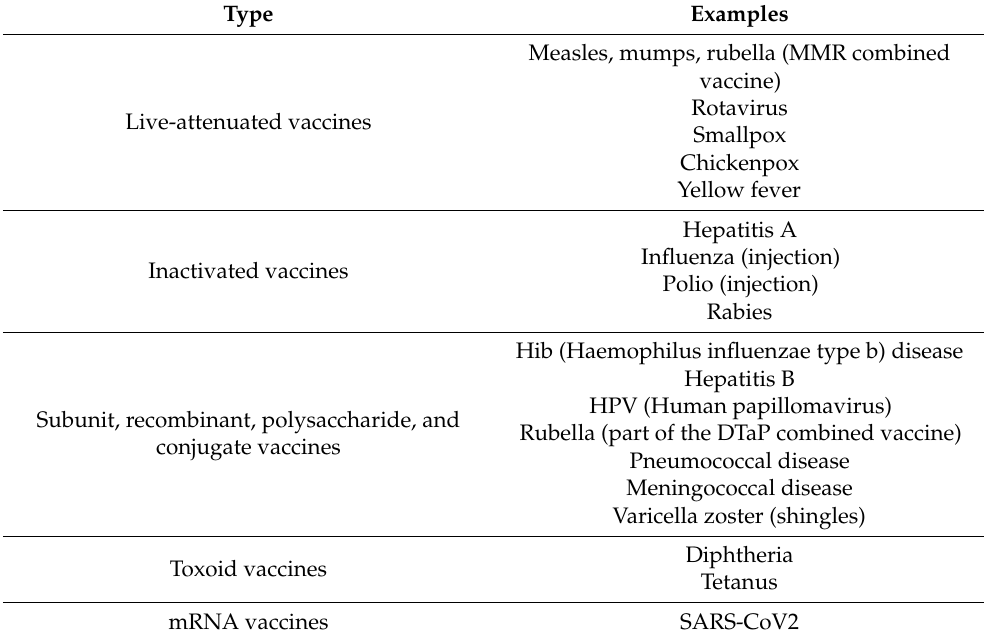
Table 4. Examples of vaccine types compiled from information presented in references